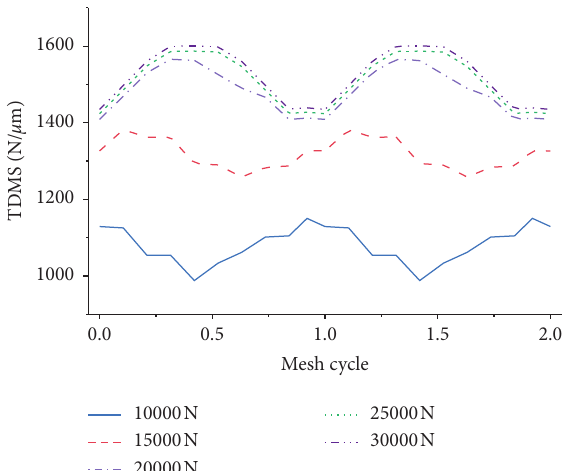
Figure 12: TDMS of the unmodified helical gear pairs under different mesh misalignment conditions.